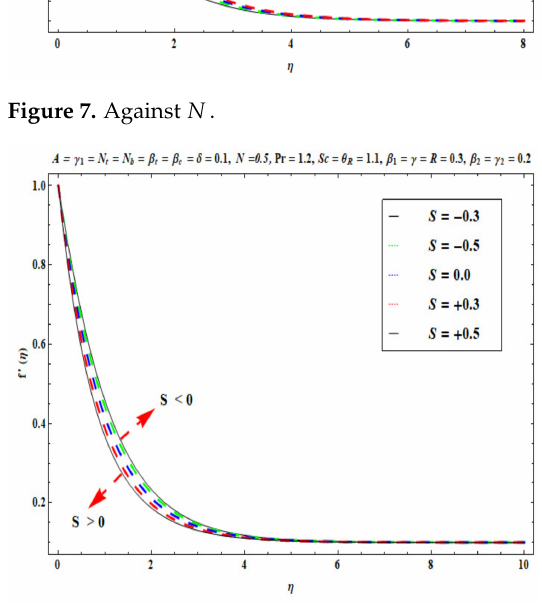
Figure 8. Against S .